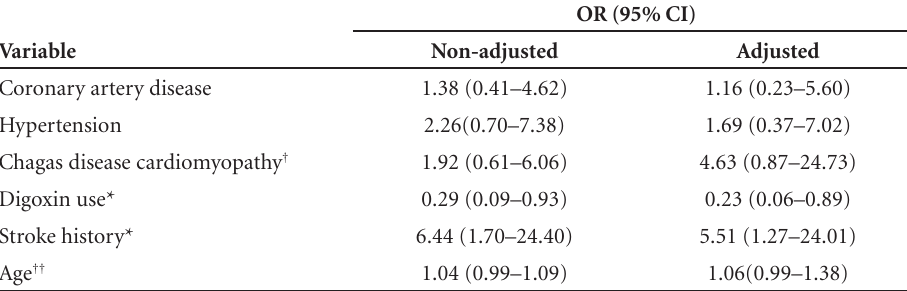
Table 3. Predictors of abnormal Mini Mental State Exam corrected for educational level. Odds ratios (OR) and 95% confidence intervals (CI) are expressed as non-adjusted and adjusted values (multivari- able logistic